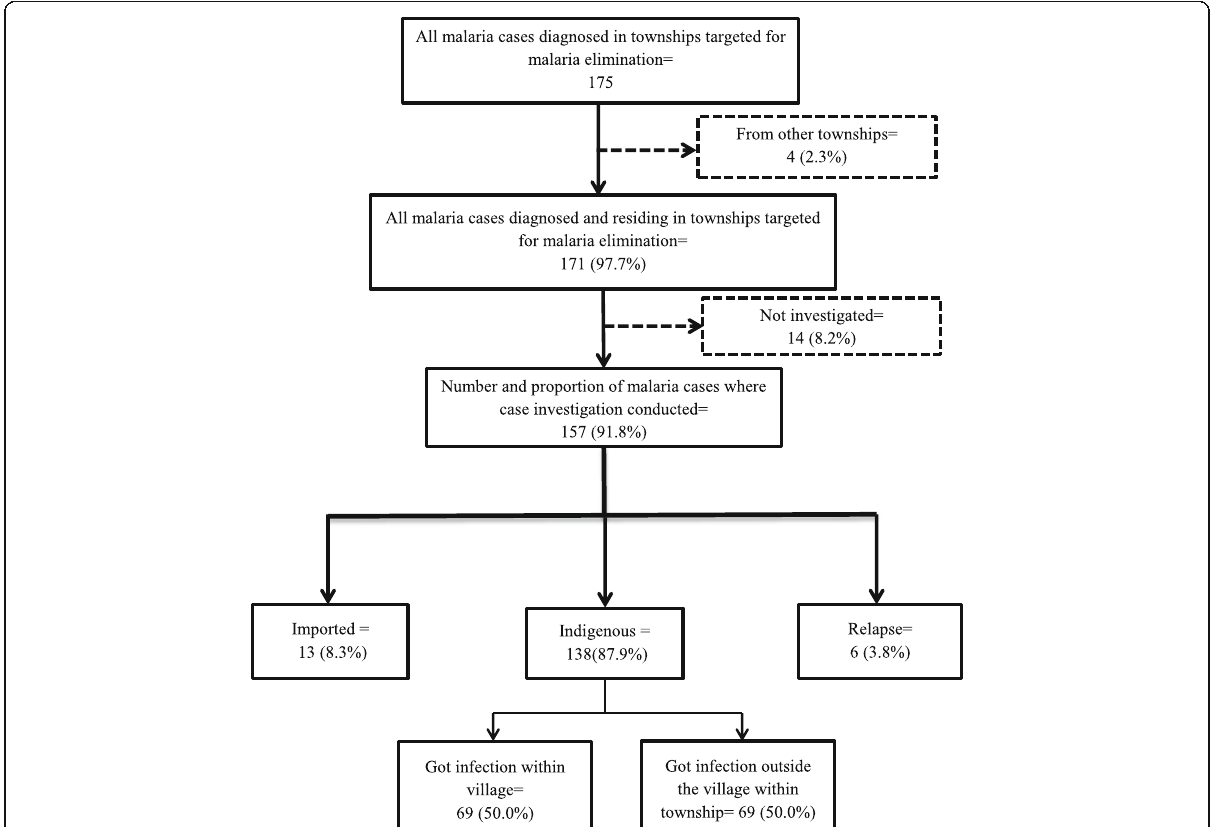
Fig. 2 Flowchart on coverage of case investigation and delay time to diagnosis among diagnosed and resident malaria